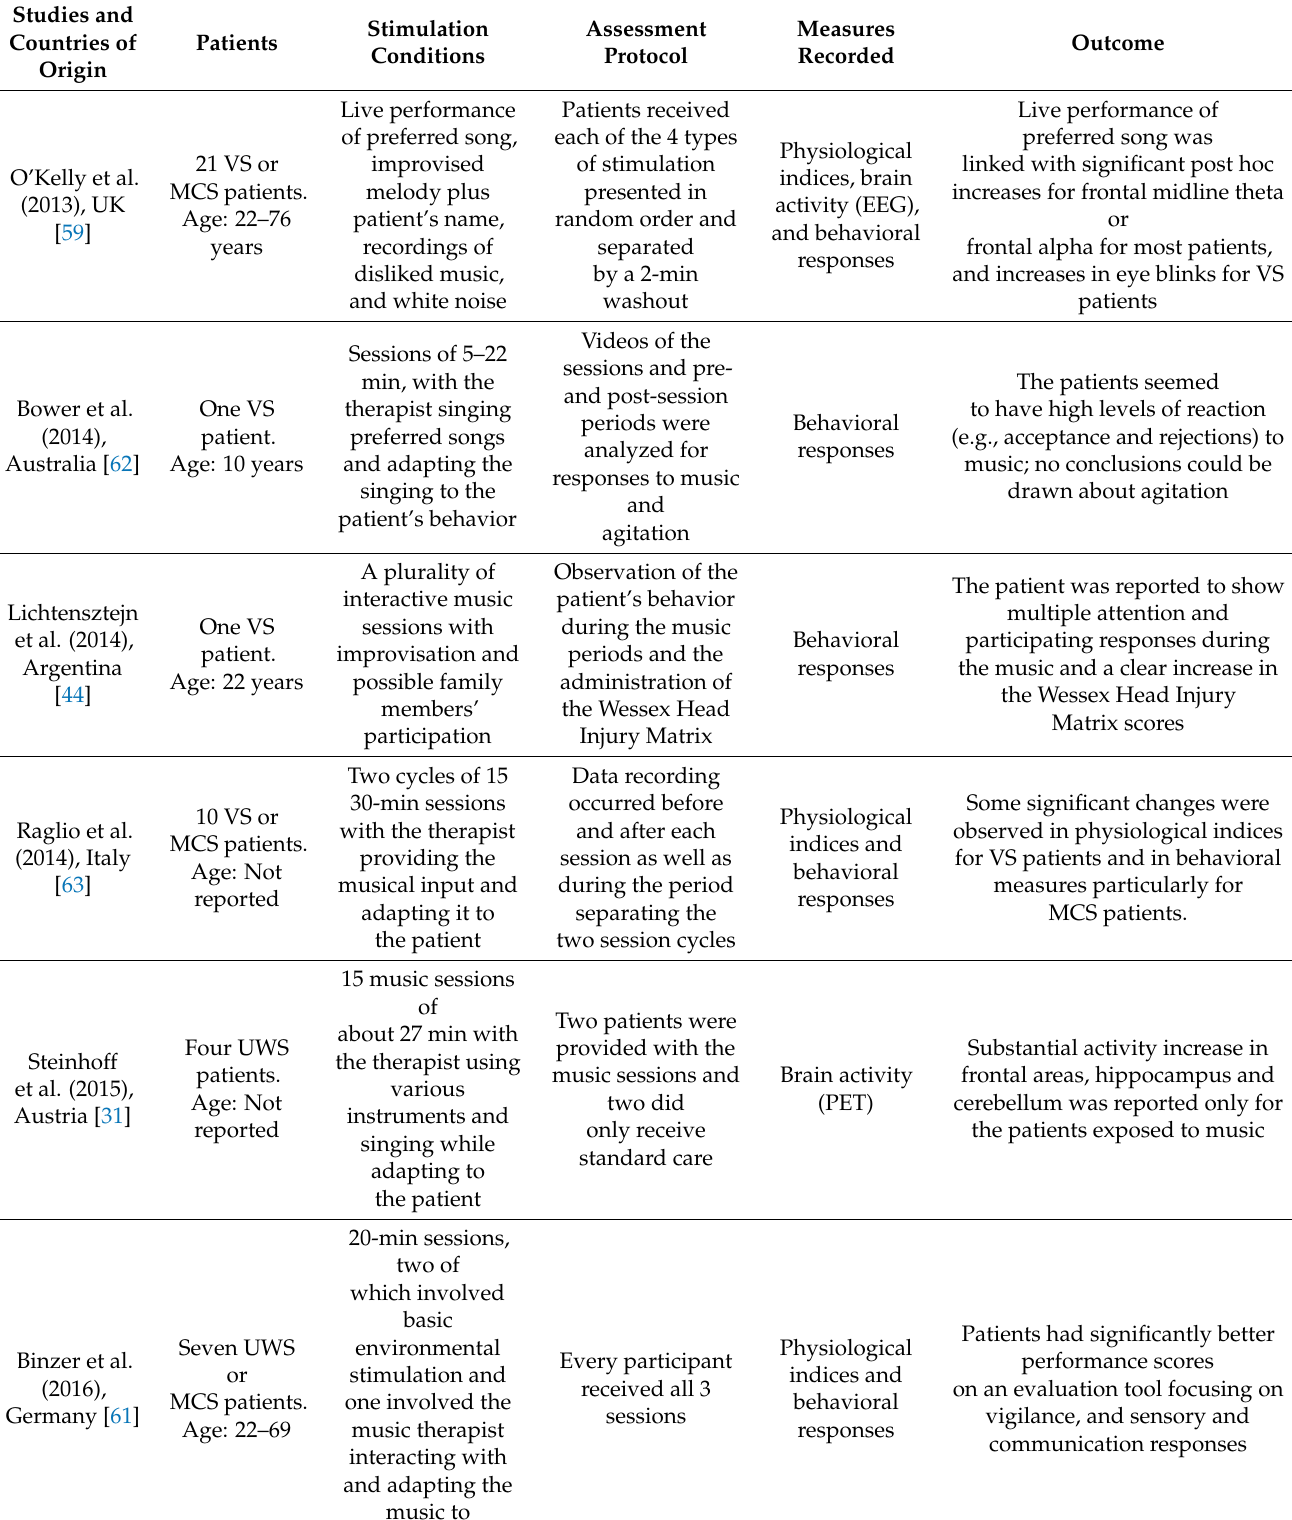
Table 2. Studies Assessing the Impact of Interactive